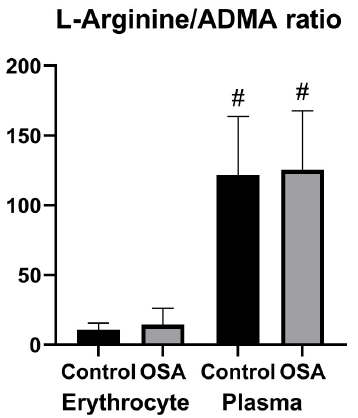
Figure 5. The NO synthase substrate (arginine) to competitive inhibitor (ADMA) ratio in plasma and erythrocytes. Bars and whiskers represent the mean ± SD. Abbreviations: ADMA: asymmetric dimethylarginine; OSA: obstructive sleep apnea. # denotes p < 0.05 vs. the erythrocyte compartment in the same group.